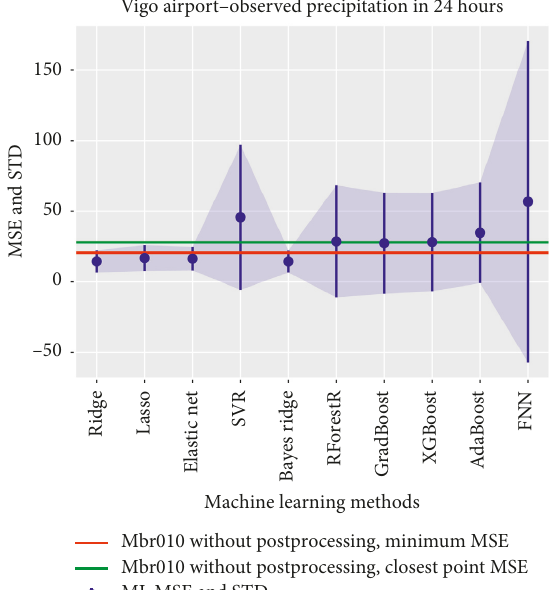
Figure 21: Precipitation in 24hours, calibration plot for Vigo airport. Horizontal axis as in Figure 18.